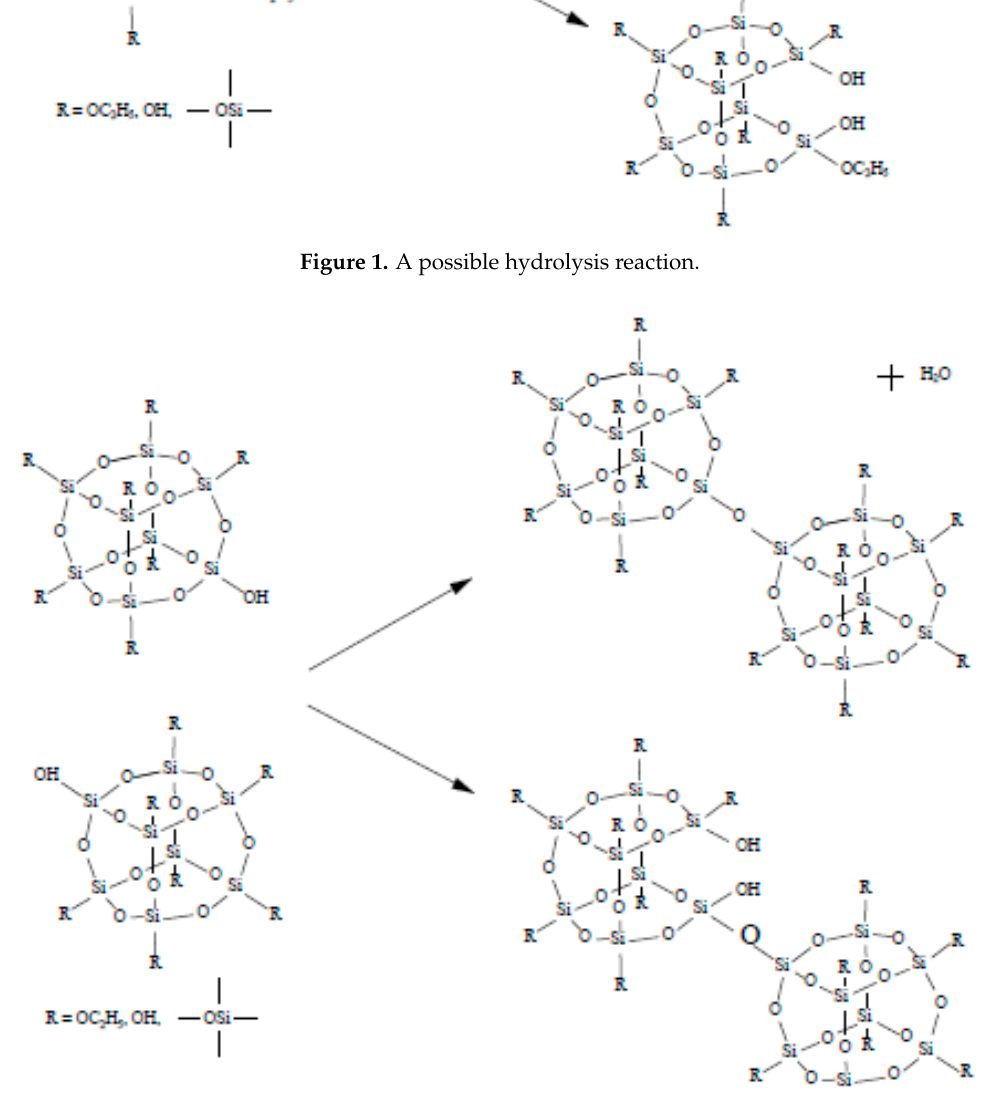
Figure 2. A possible polycondensation reaction.